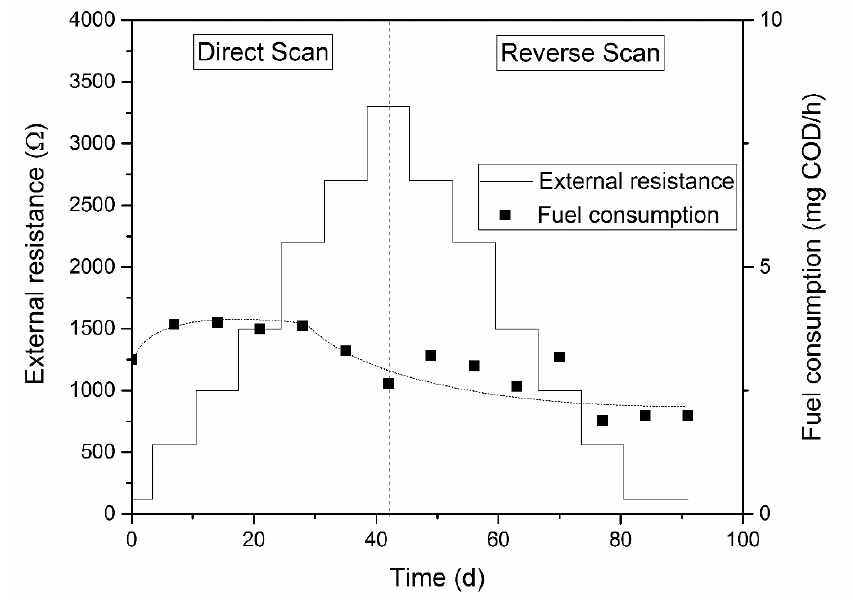
Figure 4. Fuel consumption in a steady state at every external resistance.